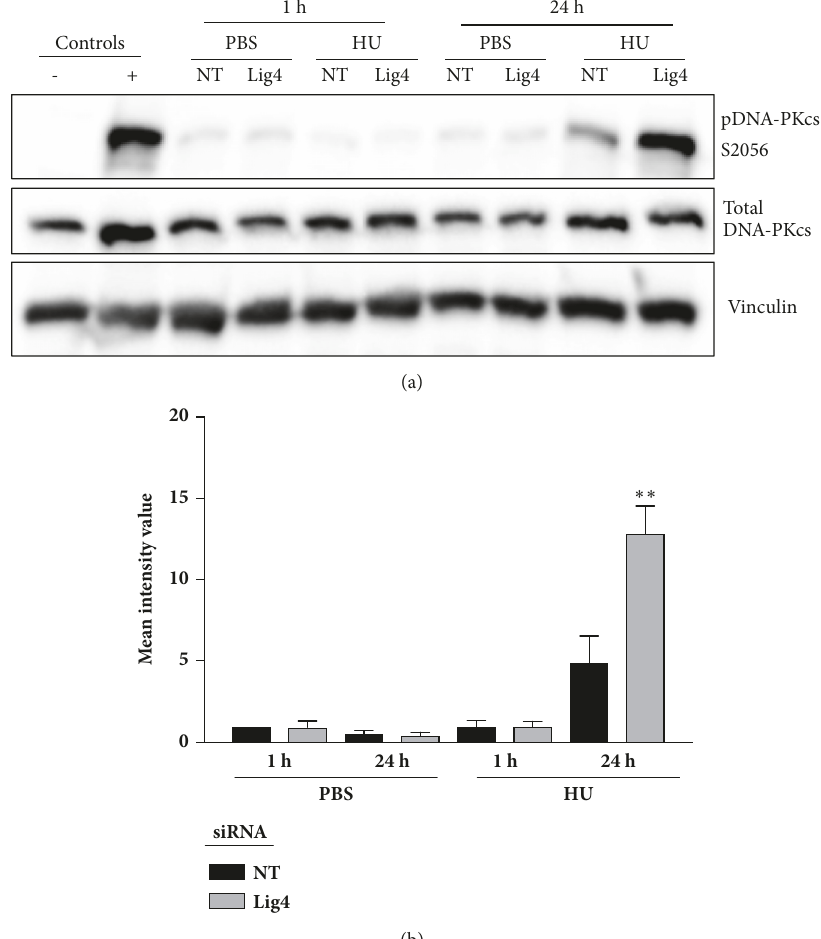
Figure 7: Lig 4 d epletion ca u ses increases in levels of pDNA - P K cs S 2056 . (a) Lig4 depleted BT549 or scrambled control (NT) treated cells were treated with HU or PBS and protein isolated as outlined in the methods section. Phosphorylation of DNA-PKcs at Ser 2056 and total DNA-PKcs levels were assessed using immunoblot. (b) Densitometry analysis of three biological replicates. Loading control (vinculin) normalized mean intensity values of pDNA-PKcs S2056 per treatment were first normalized to total DNA-PKcs followed by normalizing to control cells treated with vehicle (1 h) values ( ∗∗ p < 0.01, n=3). Untransfected BT549 cell lysate served as the negative control and lysate from 10 Gy irradiated BT549 cells served as the positive